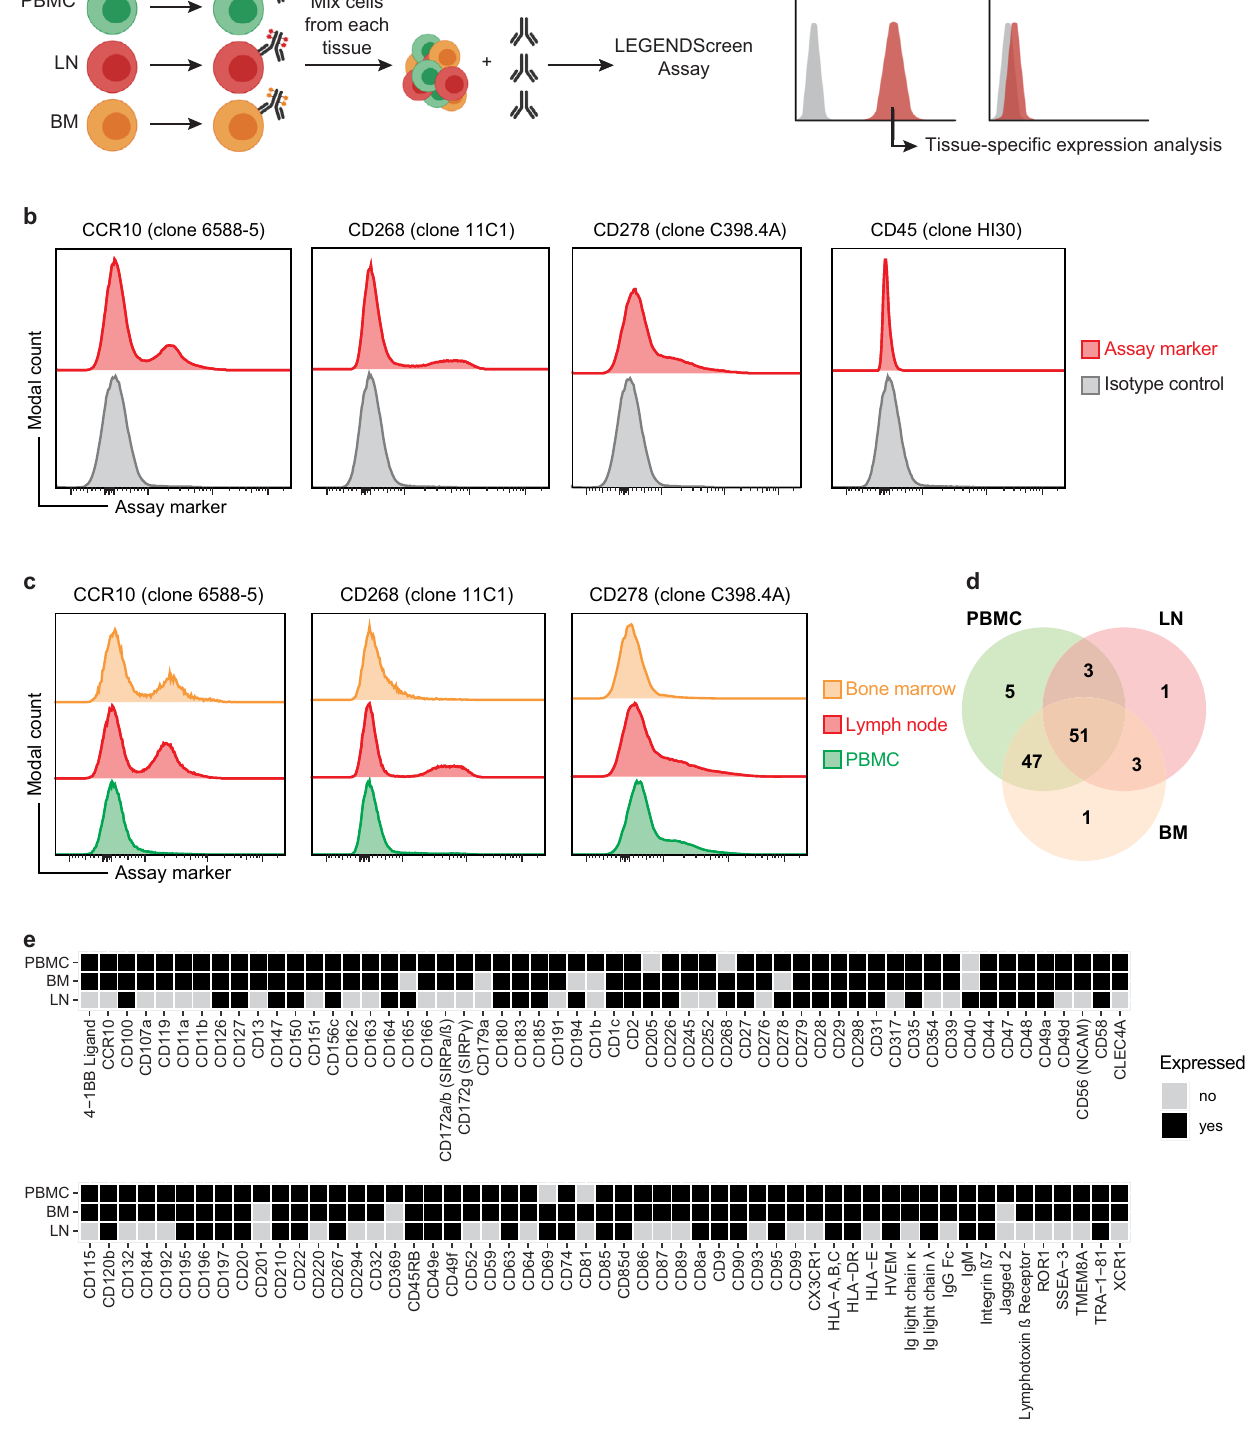
assay that allowed assessment of anti-human antibodies targeting 361 individual surface proteins (Fig. 1a). Due to the cellular yields needed to perform this assay, and the low frequency of LLPC in the BM, and the BM-residency of LLPC we choose to use isolated single-cell suspensions from NHP BM, PBMC, and LN as inputs into the assay. Cells from each of these tissues were